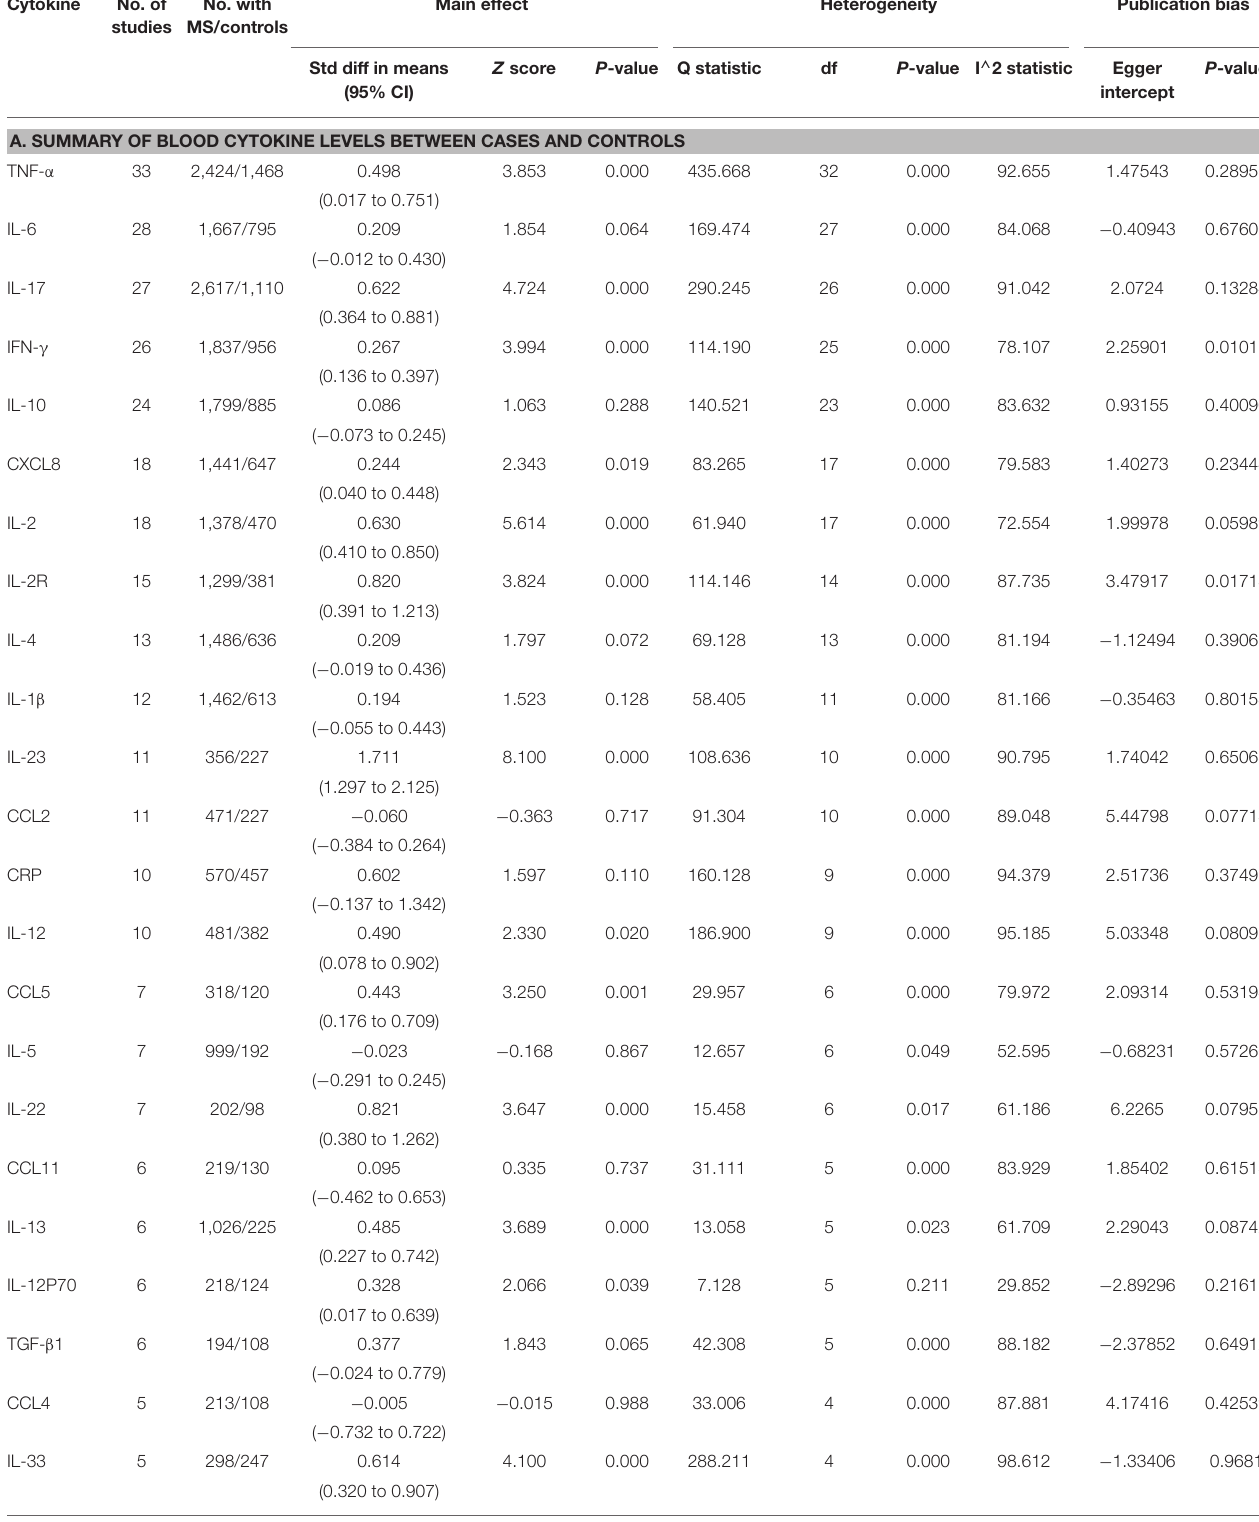
TABLE 1 | Summary of cytokine data in multiple